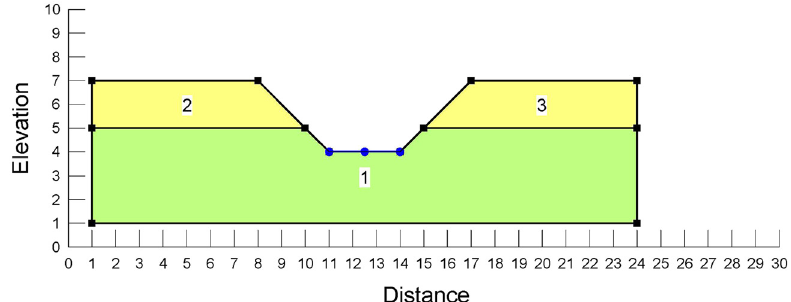
Figure 3: 2D Canal model used in SEEP/W before applying rationing system.